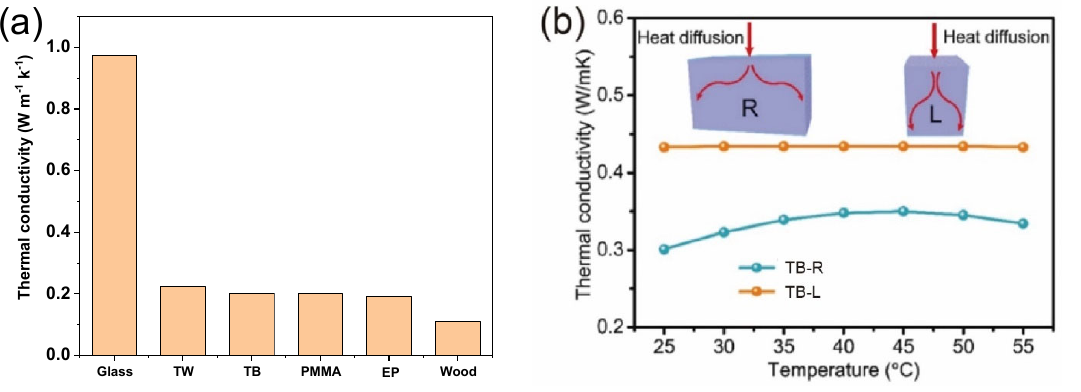
Figure 4. Thermal conductivity of TB: ( a ) comparison of the thermal conductivities of common glass, transparent wood (TW), TB, polymethyl methacrylate (PMMA), epoxy polymer (EP), and wood [23,52,53]; ( b ) thermal conductivities of TB in the longitudinal (L) and radial (R) directions [35]. (( b ) adapted from Wang et al.